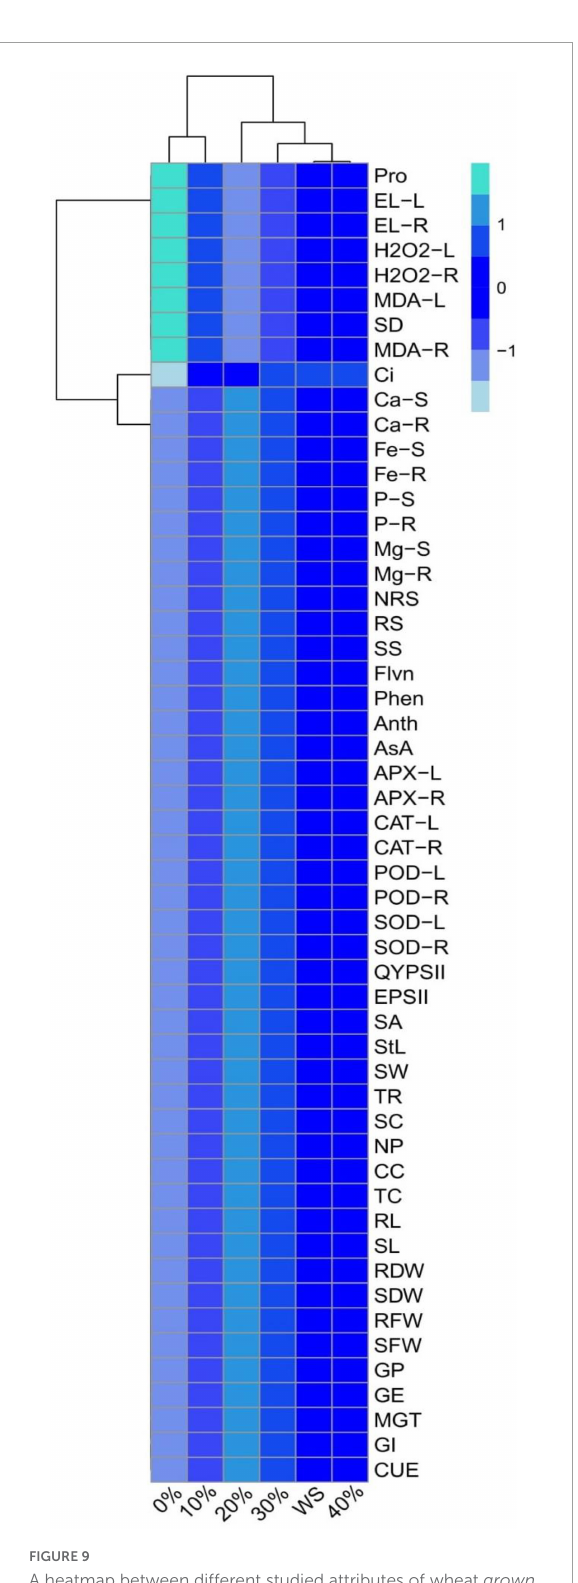
FIGURE9 A heatmap between different studied attributes of wheat grown under well-watered and drought-stressed environment. Different treatments of Plantago ovata Forsk leaf extract (POLE)